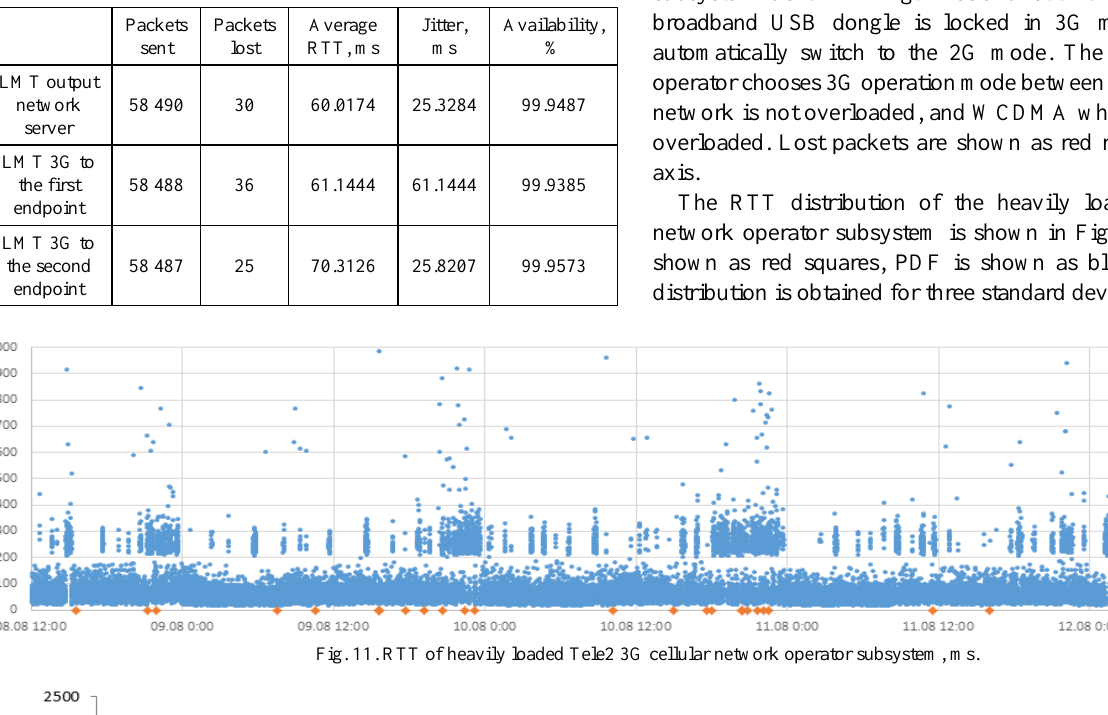
TABLE IX L IGHTLY L OADED 3G N ETWORK R ESULTS